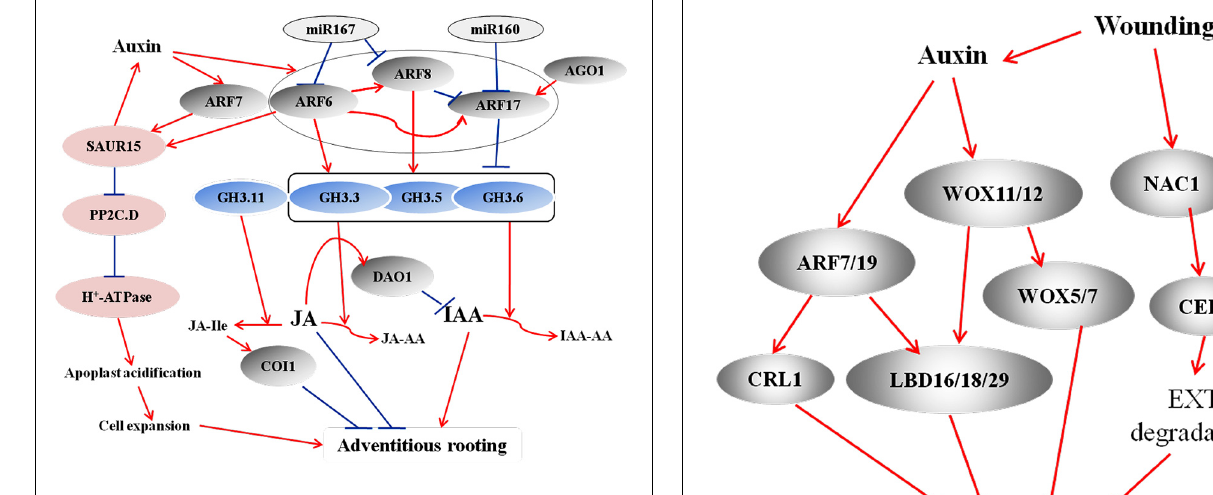
FIGURE 1 | A model illustrating how ARFs, miRNAs, and GH3s proteins regulate adventitious rooting by controlling IAA and JA homeostasis during AR formation in Arabidopsis seedlings. Auxin controls adventitious root initiation by activating ARF6 and ARF8, leading to the downregulation of inhibitory COI1 signaling (Gutierrez et al., 2009, 2012). ARF6, ARF8, and ARF17 and their regulatory miRNAs interact in a complex network and act upstream of GH3.3 , GH3.5 , and GH3.6 . ARF6 and ARF8 are positive regulators of these three GH3 genes, whereas ARF17 is a negative regulator. The three GH3 proteins control free IAA levels and JA homeostasis. The JA level determines the JA-Ile level. JA-Ile negatively regulates adventitious rooting by activating the COI1 signaling pathway. AGO1 upregulates GH3 genes by downregulating ARF17 , thereby regulating adventitious rooting through this pathway, as well. Another feedback circuit consist of DAO1, IAA, and COI1-dependent JA signaling. COI1-dependent JA signaling actives the expression of DAO1, which in turn regulates IAA homeostasis by irreversible degradation (Lakehal et al., 2019b). Copeland (2020) and Yin et al. (2020) proposed a model of the involvement of SAUR15 in auxin signaling-mediated AR formation in Arabidopsis seedlings. ARFs directly bind to the promoter of SAUR15 to activate its expression. SAUR15 promote AR formation via two pathways. SAUR15 inhibit PP2C.D activity, leading to the release of membrane H + -ATPase activity, which then causes apoplastic acidification and cell expansion, thereby facilitating AR emergence. SAUR15 also activates auxin biosynthesis to promote AR formation. Red arrows represent positive regulation, and blue bars represent negative regulation.